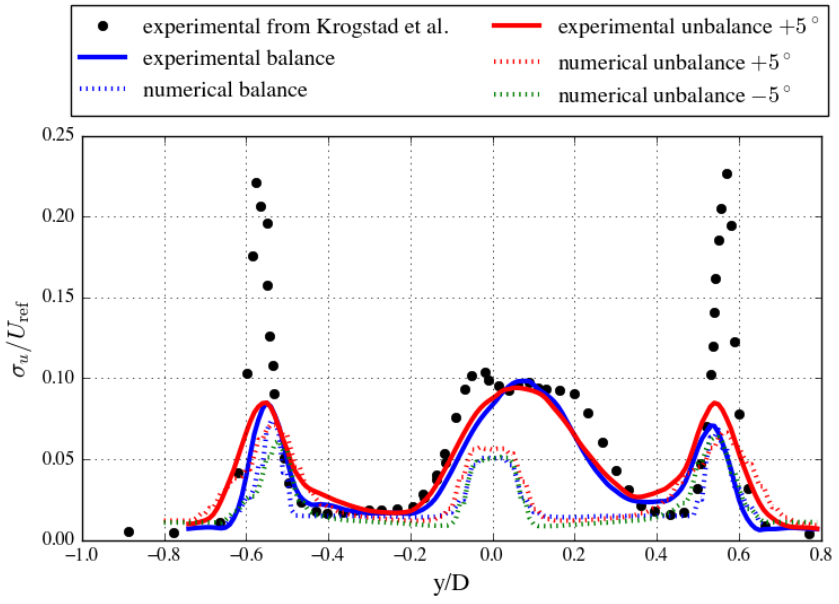
Figure 15. Numerical and experimental profiles of the normalised velocity standard deviation at hub height for the balanced and unbalanced cases at x / D = 1. See Figure 11 for the list of symbols.